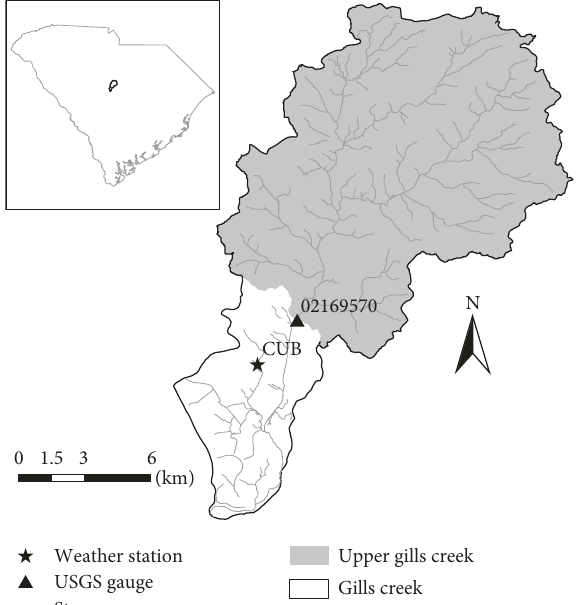
Figure 1: Gills Creek watershed and associated stations for flood simulation.